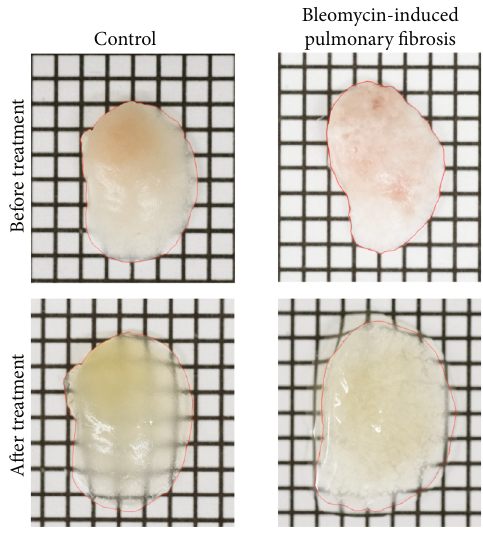
Figure 3: Transmission color images of fi brotic lung tissues from mice after Clear T2 tissue-clearing treatment. Each square represents 2 × 2mm 2 . Red lines show the shape of lung